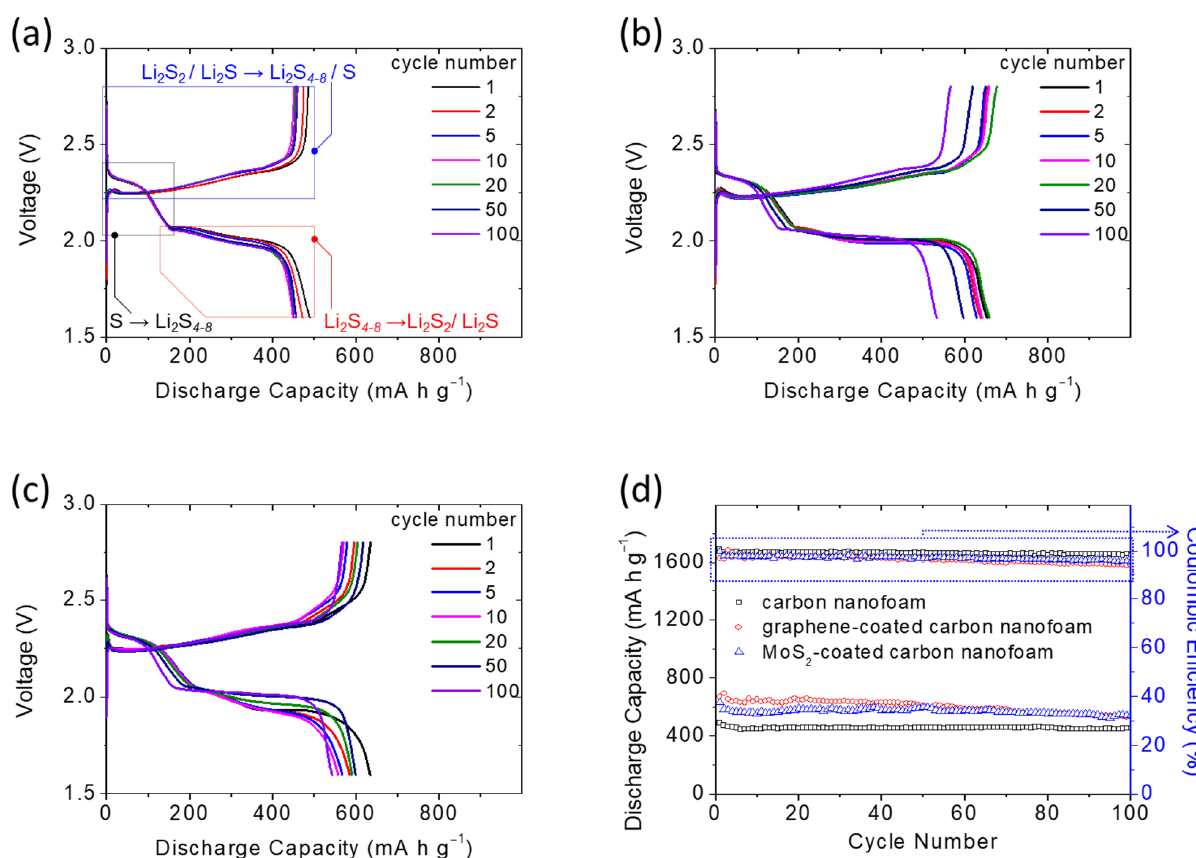
Figure 4. Electrochemical performance: discharge/charge voltage profiles of sulfur cathodes with ( a ) the carbon nanofoam, ( b ) the graphene-coated carbon nanofoam, and ( c ) the MoS 2 -coated carbon nanofoam. ( d ) Cyclability at the C/10 rate.